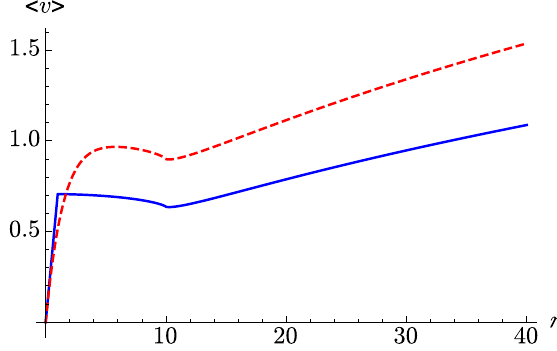
Figure 4. Blue curve from ρ 1 , and red dashed curve from ρ 2 . Both curves with α = 1 and β = 0.1.